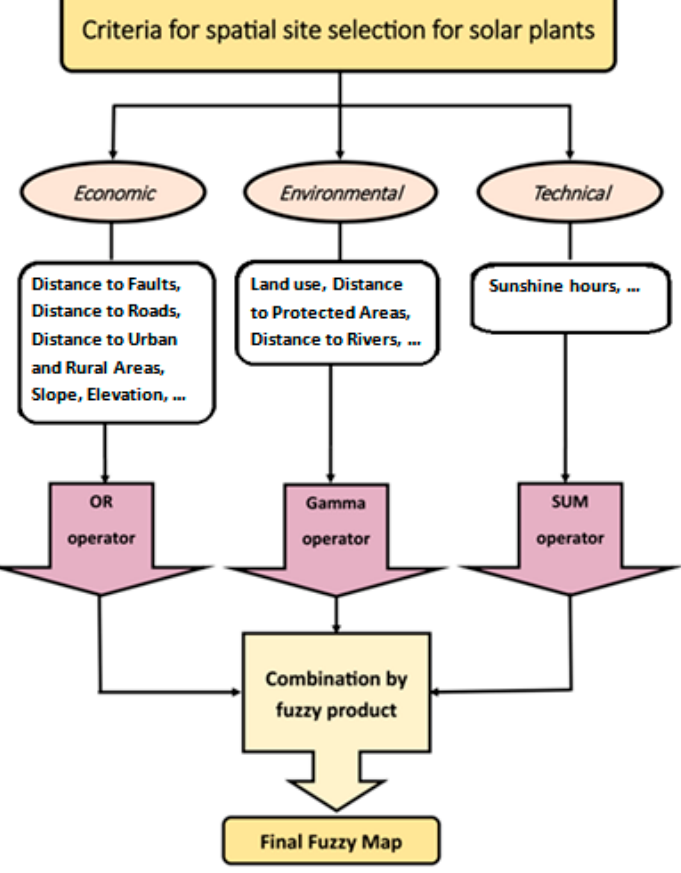
Figure 2. Diagram of the integration of criteria.